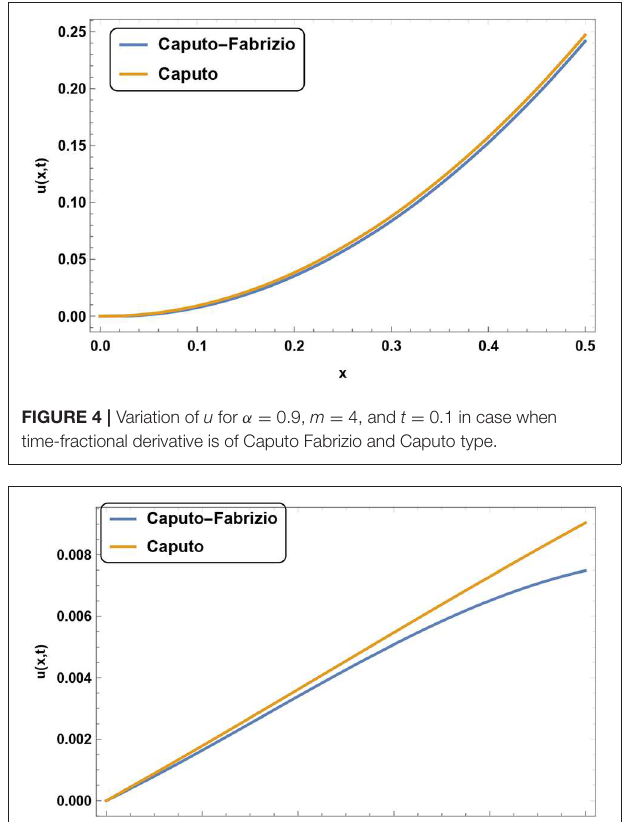
FIGURE 7 | 3D-plot of absolute error for m =